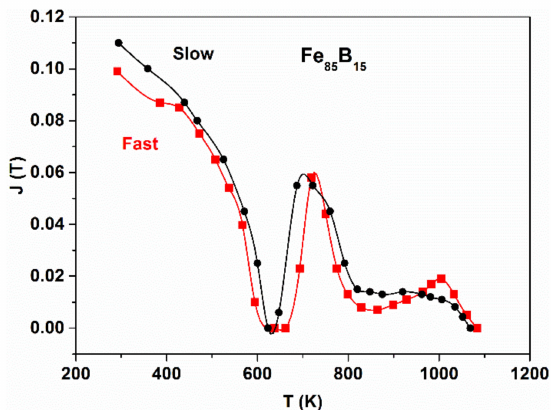
Figure 5. Thermomagnetic curves, ( M ( T )), for Fe 85 B 15 glass, prepared by fast and slow cooling. Adopted from [54], with permission from Springer Nature,